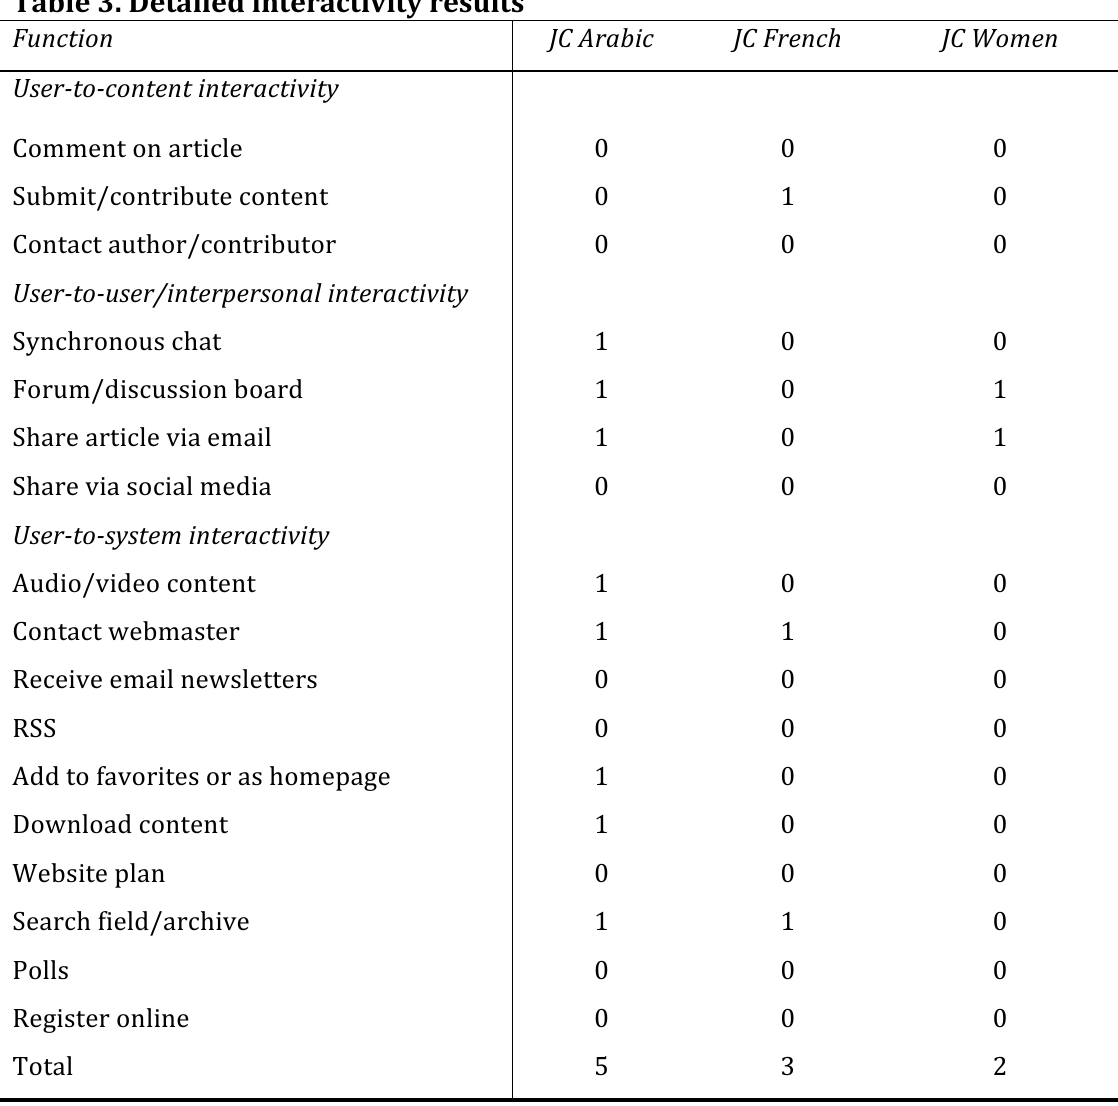
Table 3. Detailed interactivity results